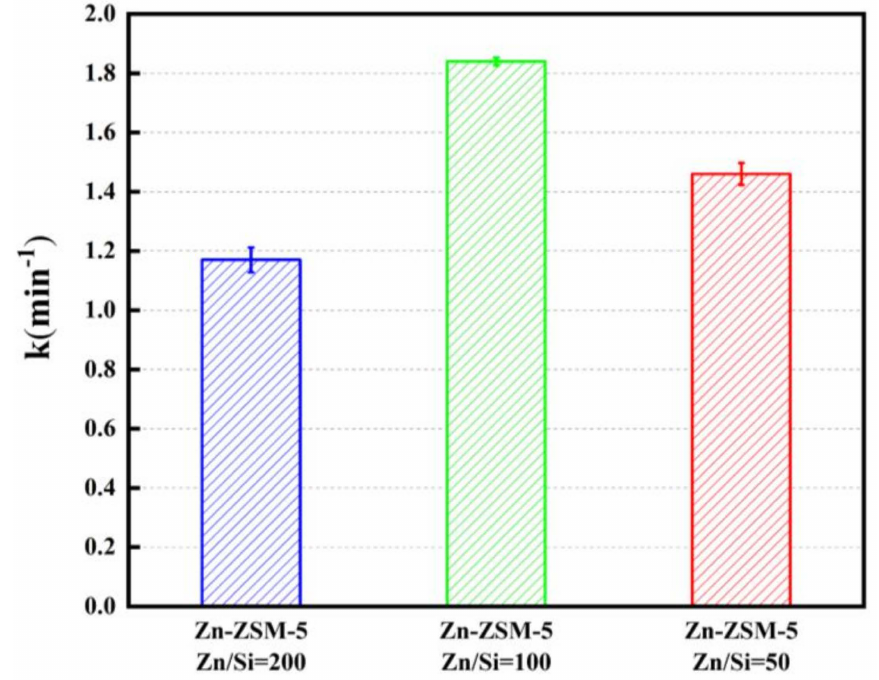
Figure 11. Photocatalysis kinetic constants of the evaluated